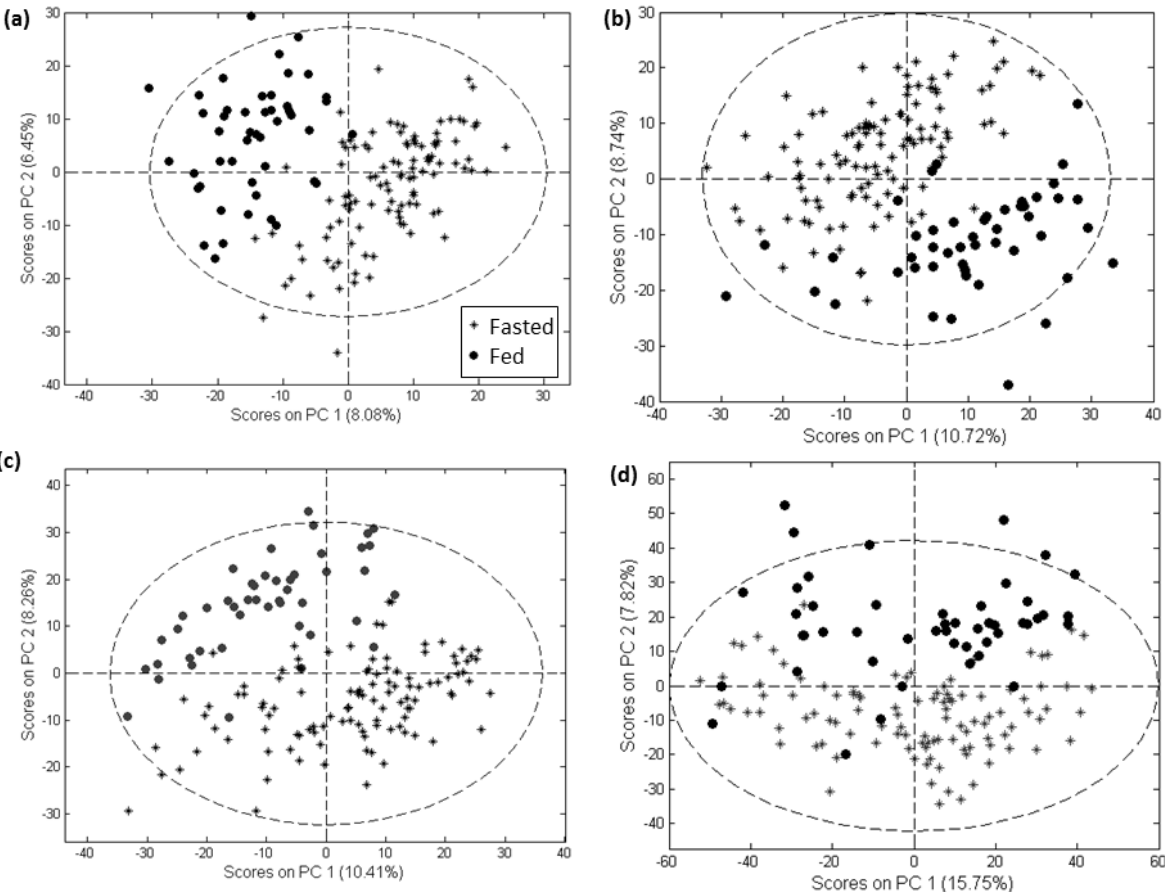
Figure 2. PCA scores plots of negative mode data processed with MarkerLynx ( a